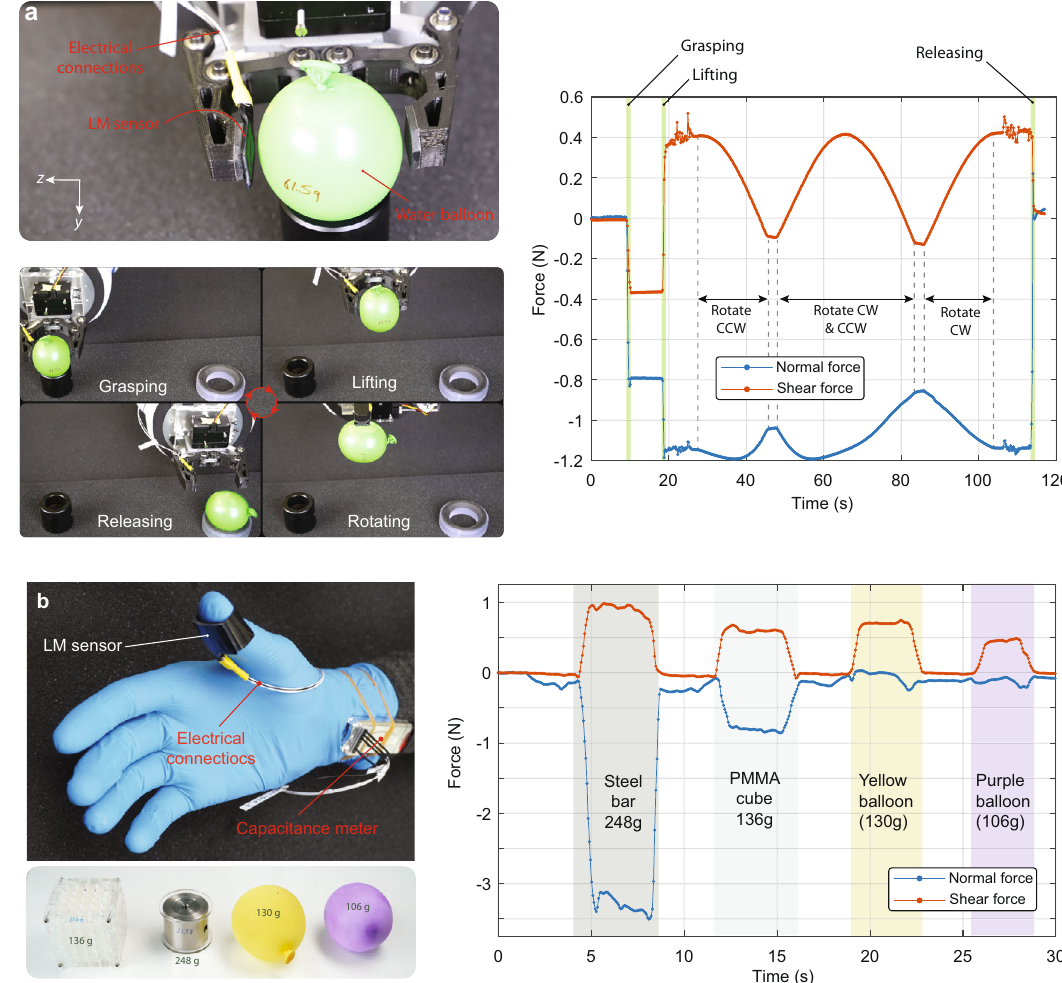
Fig.7|interactionforcesmeasuredbythesoftsensorduringthemanipulation of various objects. a The soft sensor is attached to a fi nger of a robotic gripper and is used to measure the normal and shear forces when a water balloon is grasped, lifted, rotated, and released. The plot shows the time evolution of the force components during this manipulation. b The soft sensor mounted on a